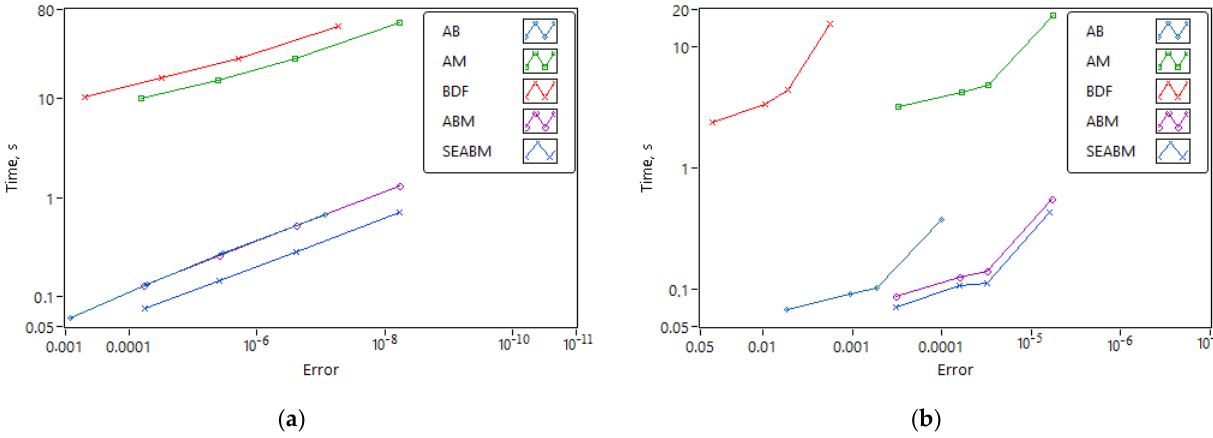
Figure 7. Performance plots for investigated multistep ODE solvers while simulating three-body problem with ( a ) fixed integration step; ( b ) variable integration step.